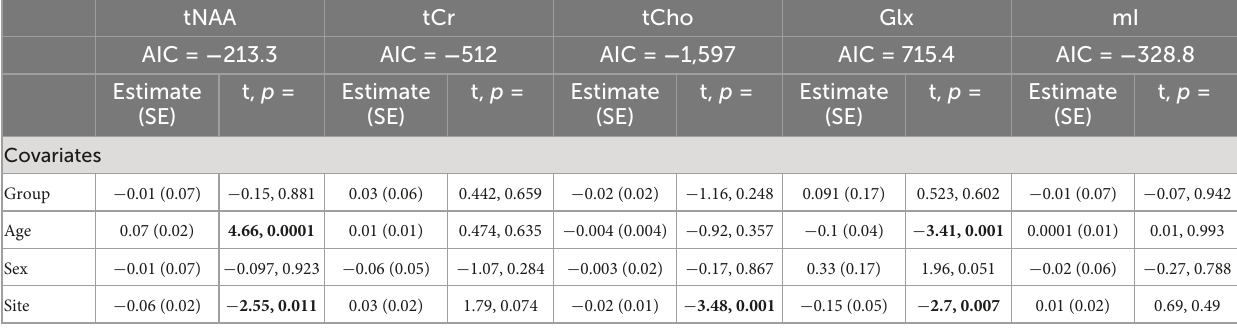
TABLE 6 Summary of the independent univariate general linear model (GLM) models for each metabolite to investigate group differences (concussion vs. OI) in tNAA, tCr, tCho, Glx, and mI.